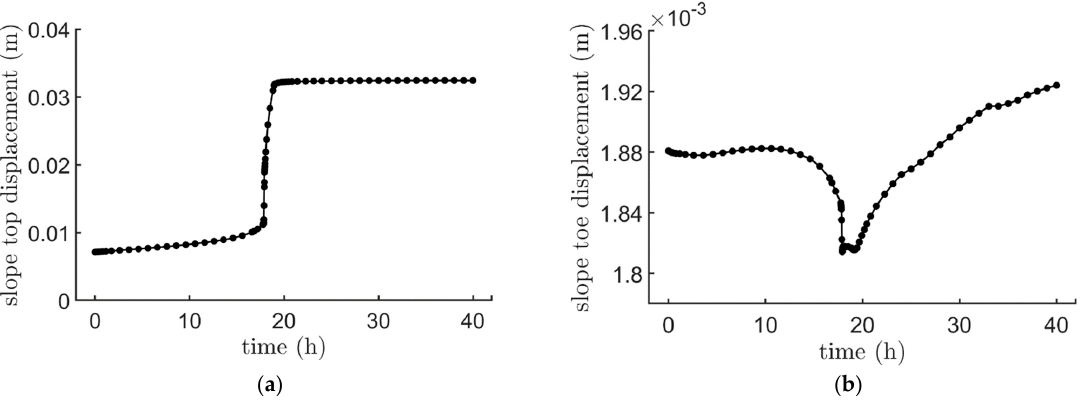
Figure 6. Variations of displacement in the FE infiltration analysis (displacement amplified by 100): ( a ) t = 10.6 h; ( b ) t = 18 h; ( c ) t = 20 h.